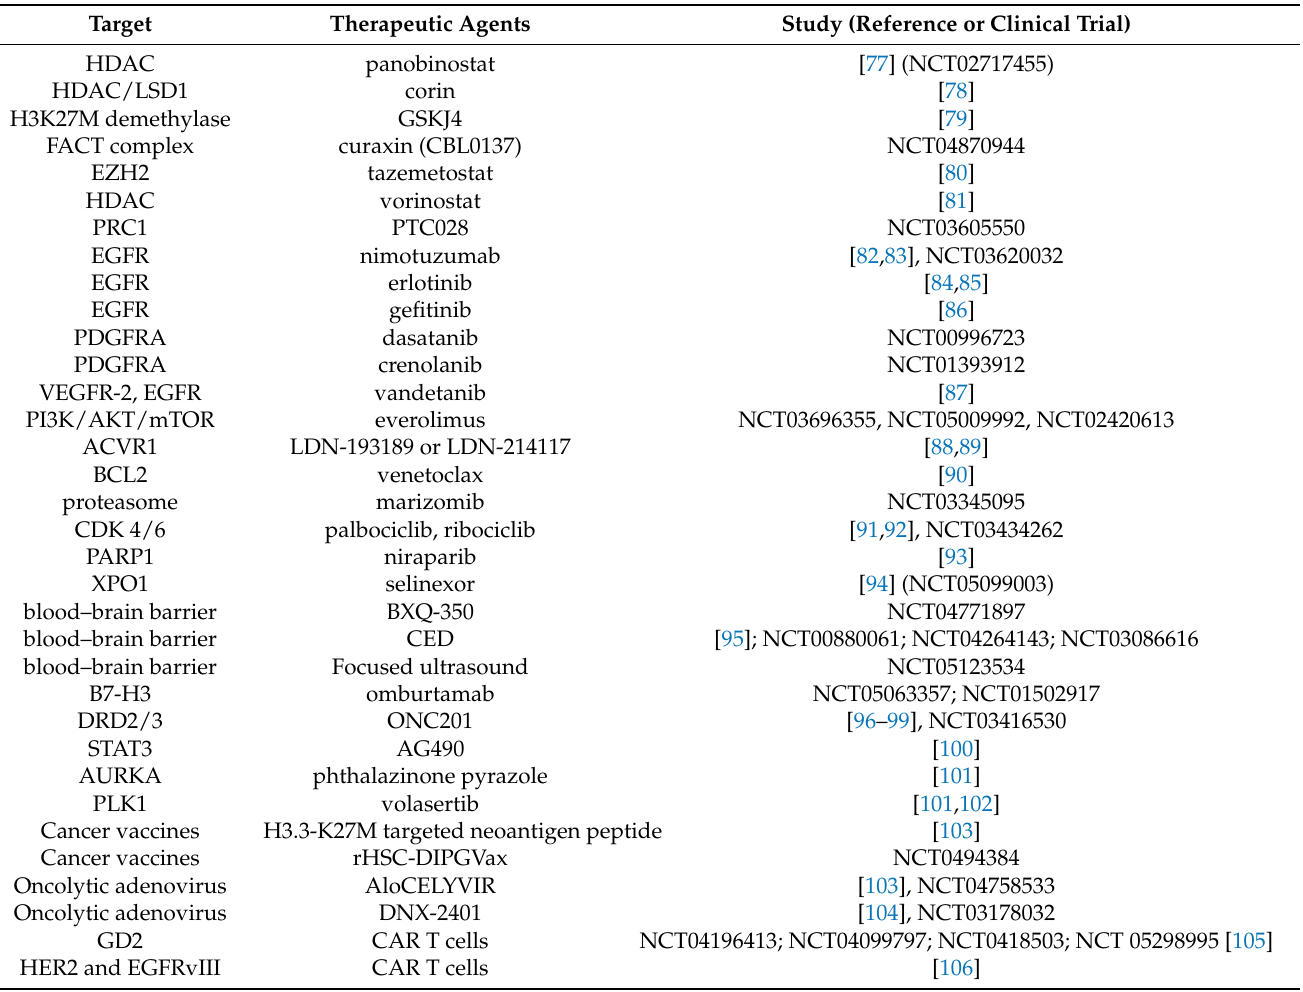
Table 4. Molecularly targeted agents in clinical development for the treatment of DMG. Details are provided in the main